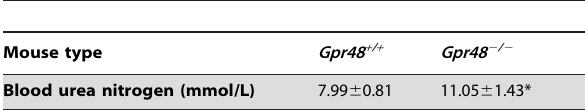
Table 2. The content of blood urea nitrogen in Gpr48 + / + and Gpr48 2 / 2